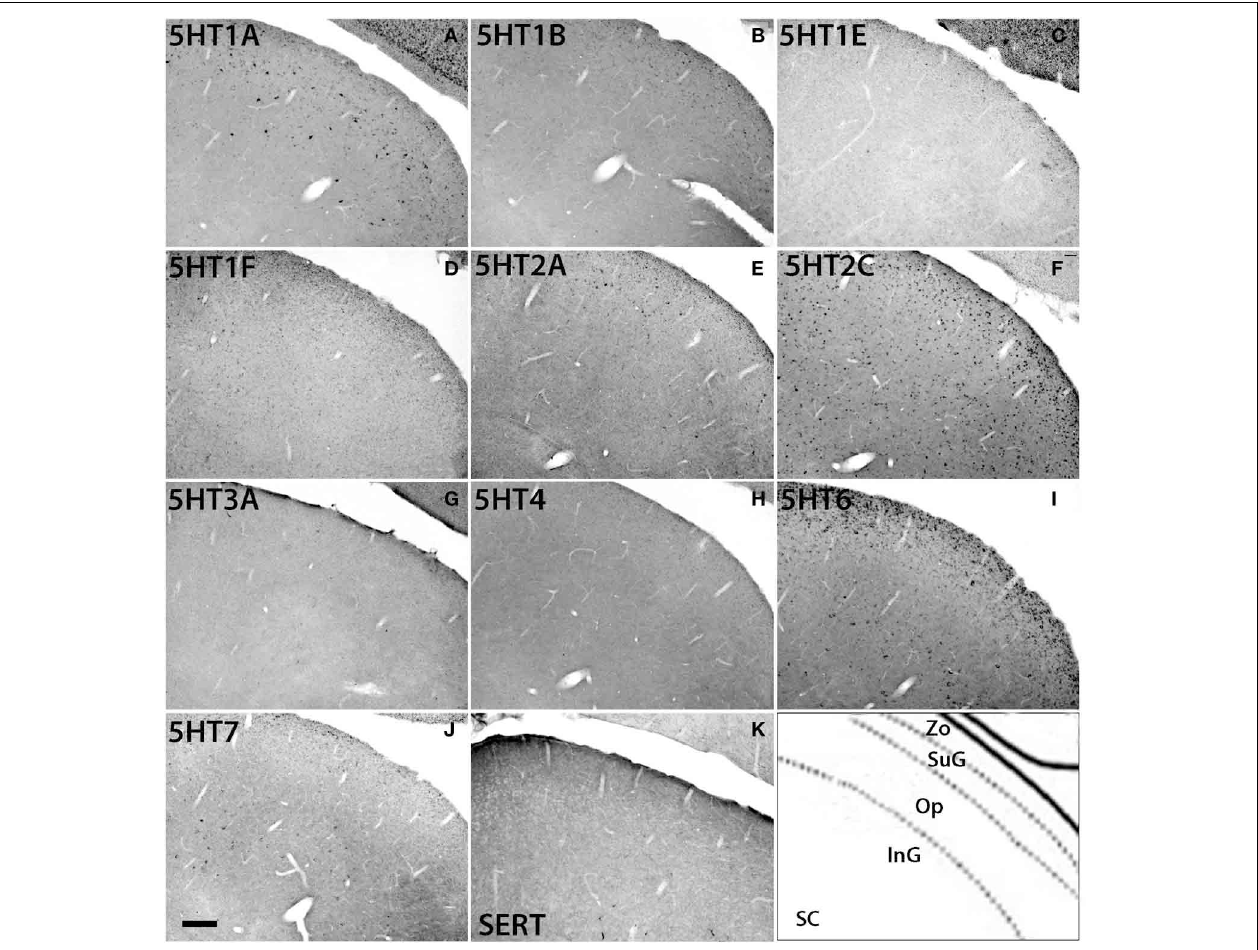
FIGURE 11 | ISH expression profiles of 5HTR s in superior colliculus. 5HTR mRNA expressions (A–J) and immunohistochemical staining with anti-SERT antibody (K) in zonal layer (Zo), superficial gray (SuG), optic